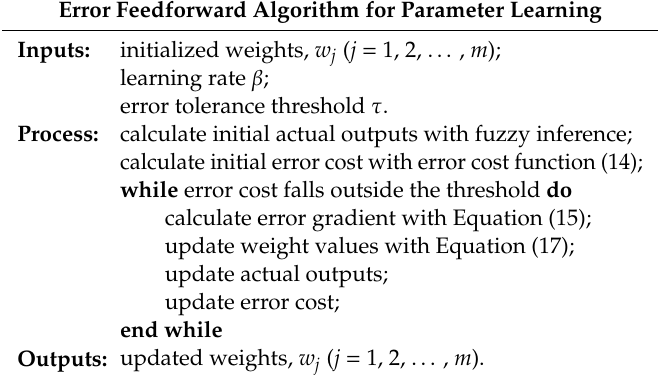
Table 1. Formalized description of the error feedforward algorithm.